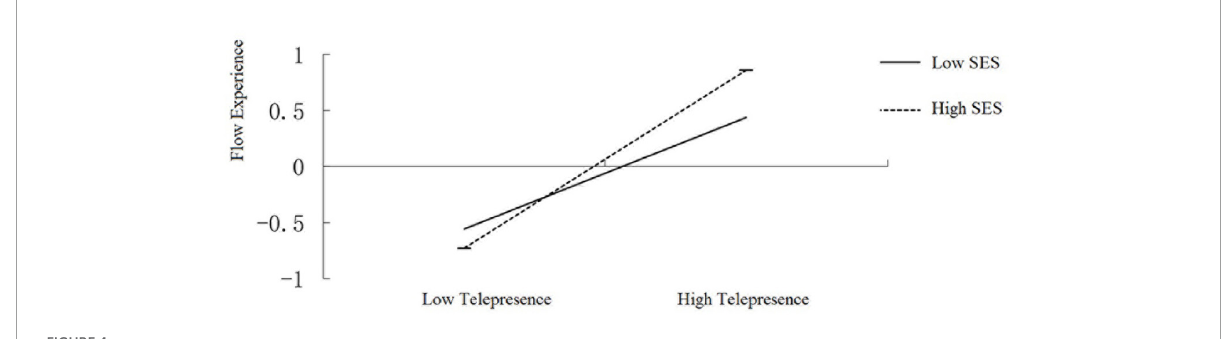
FIGURE4 The slope diagrams about moderating effect of socioeconomic